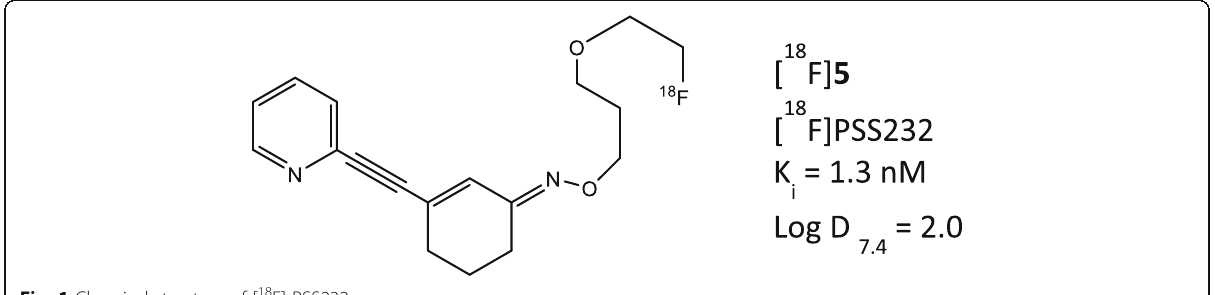
Fig. 1 Chemical structure of [ 18